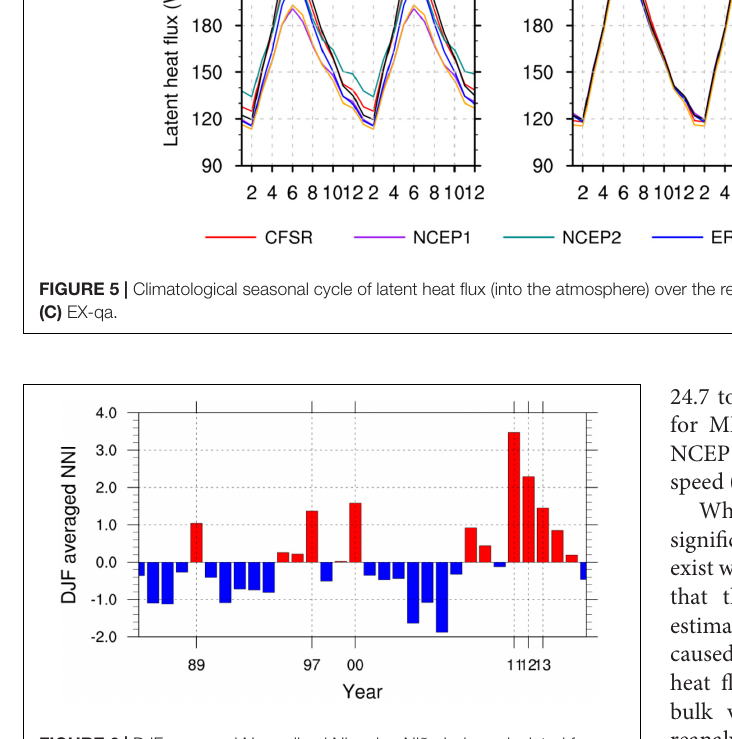
FIGURE 6 | DJF averaged Normalized Ningaloo Niño Index calculated from the NOAA 1/4 ◦ daily Optimum Interpolation Sea Surface Temperature. The year shown in the horizontal axis corresponds to the year of January and